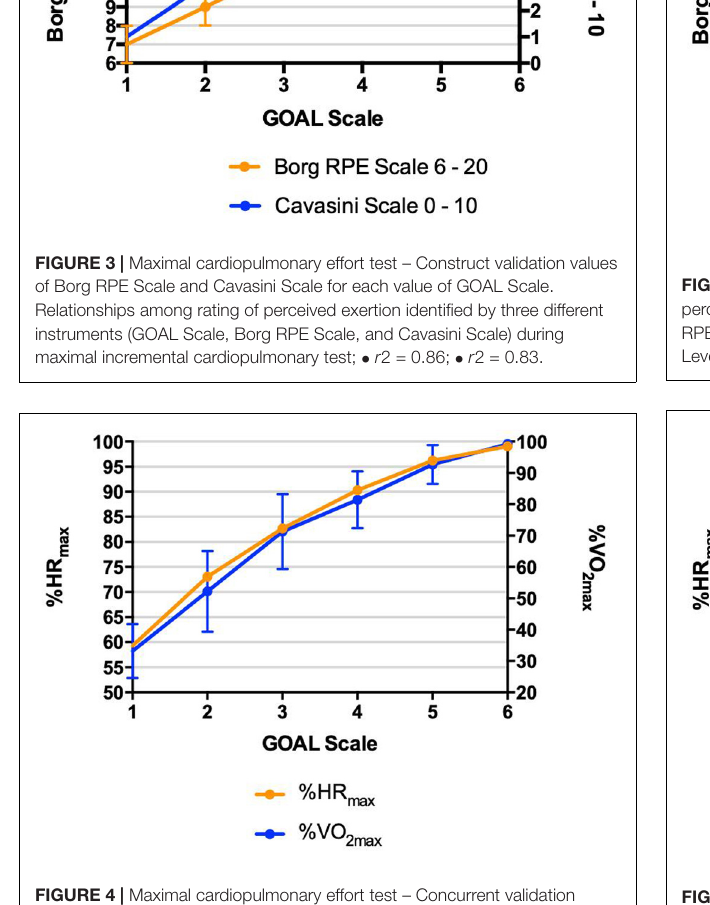
FIGURE 6 | Yo-Yo Test – Concurrent Validation Relationships among rating of perceived exertion identified by GOAL Scale and physiological parameters (heart rate percentage – %HR max and blood lactate concentration) during Yo-Yo Intermittent Recovery Test – Level 1; • r 2 = 0.73; • r 2 =